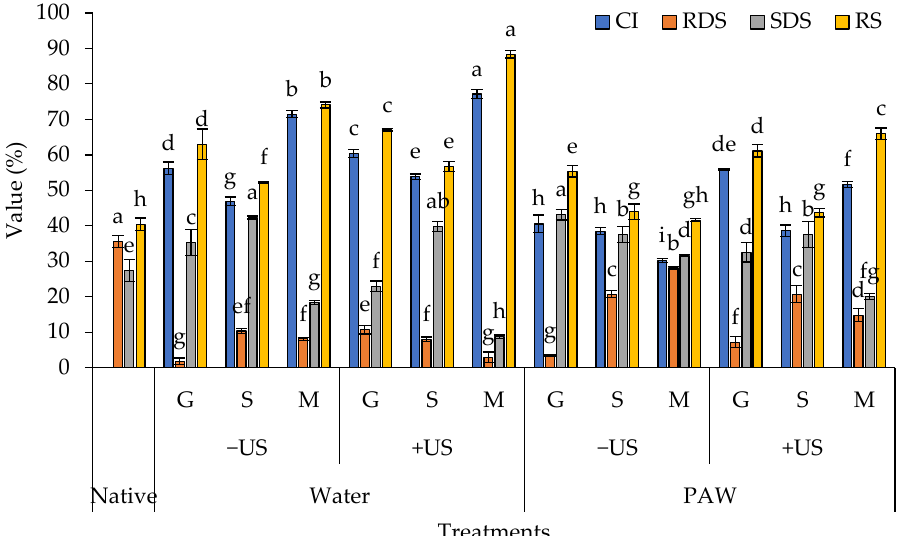
Figure 1. Complexing index (CI), rapidly digestible starch (RDS), slowly digestible starch (SDS), and resistant starch (RS) of rice starch – phenolic complexes. Different phenolic compounds — gallic acid (G), sinapic acid (S), and crude Mon-pu ( Glochidion wallichianum Muell Arg) (MP) extract — were complexed with hydrothermally pre-gelatinized rice starch prepared using distilled water (Water) or plasma-activated water (PAW) without ( − US) and with (+US) the aid of ultrasonication. The native starch (Native) was used to compare. Bars represent the standard deviations from triplicate determinations. Different letters on the bars indicate the significant differences ( p < 0.05).